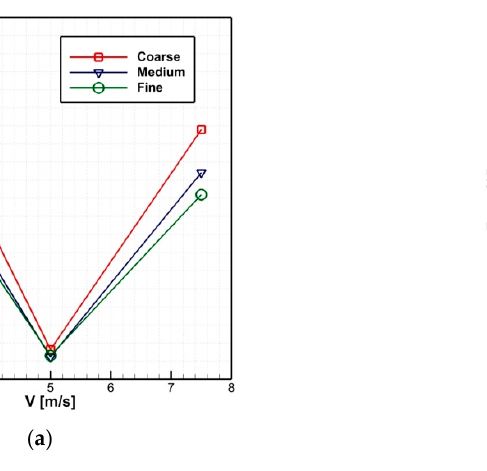
Figure 6. Numerical errors for: ( a ) grid- and ( b ) time-step-convergence studies.